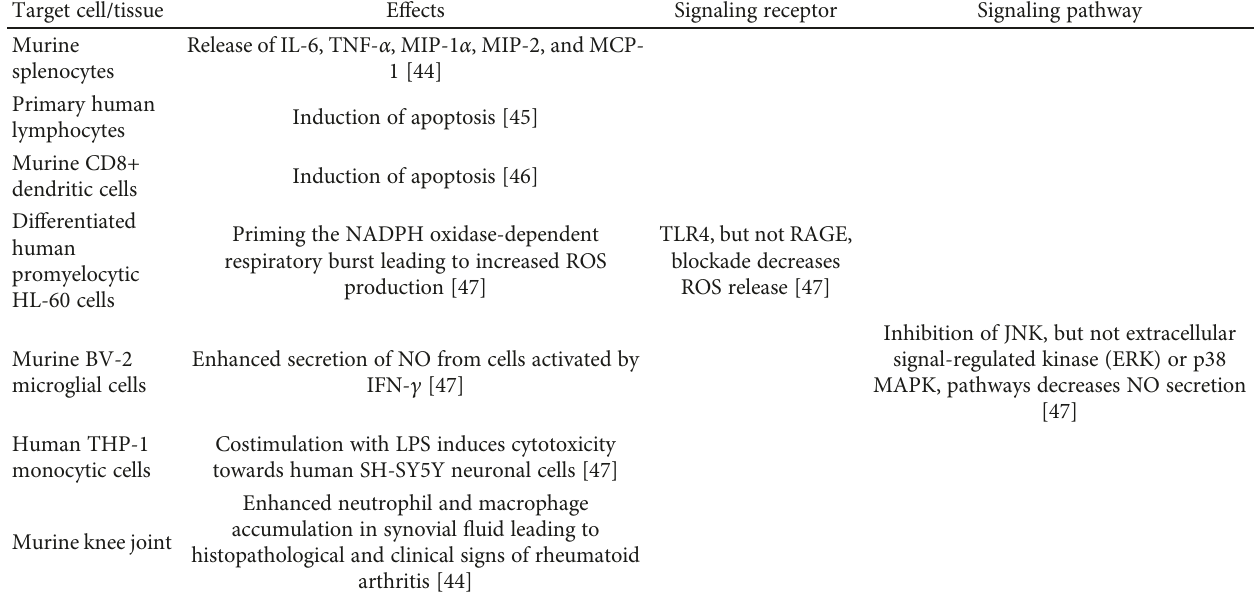
Table 1: E ff ects of extracellular CytC on di ff erent cell types and signaling mechanisms activated in the target